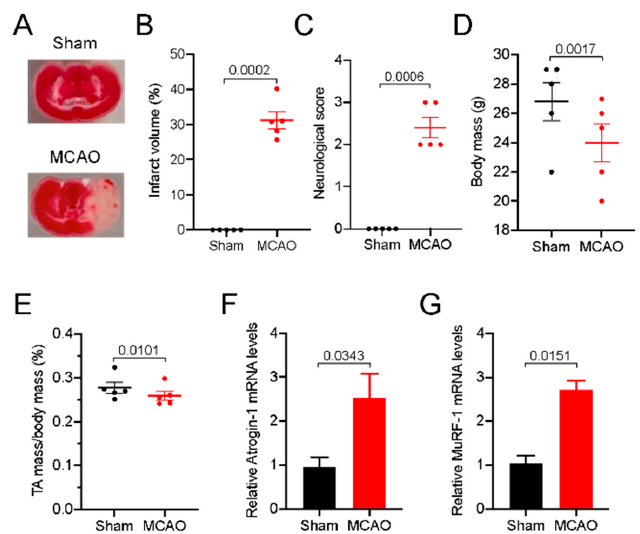
Figure 1. Stroke causes brain lesion, muscle wasting, and motor dysfunction. Male C57BL/6J mice were subjected to 45 minutes middle cerebral artery occlusion (MCAO) or sham surgery followed by 72h reperfusion. (a) Representative TTC-stained 1 mm coronal brain sections of mid cortex region indicating areas of healthy (red area) and ischemic injury (white area) tissues after 72h of reperfusion. (b) Size of the lesion in the ipsilateral hemisphere expressed as a % of the total contralateral hemisphere volume (n = 5). (c) Neurologic deficits were measured by the modified neurological severity score (0 is normal; n = 5/group). (d-e) Body mass (d) and PTA and CTA muscle mass normalized to body mass (e). (f-g) Total RNA was extracted from the PTA and CTA muscle of sham and MCAO mice (n = 4) and used in RT–qPCR to determine the mRNA levels of atrogin-1 (f) and MuRF-1 (g). Values in each graph indicate the mean ± SEM. PTA: Paretic tibialis anterior; CTA: the corresponding tibialis anterior.